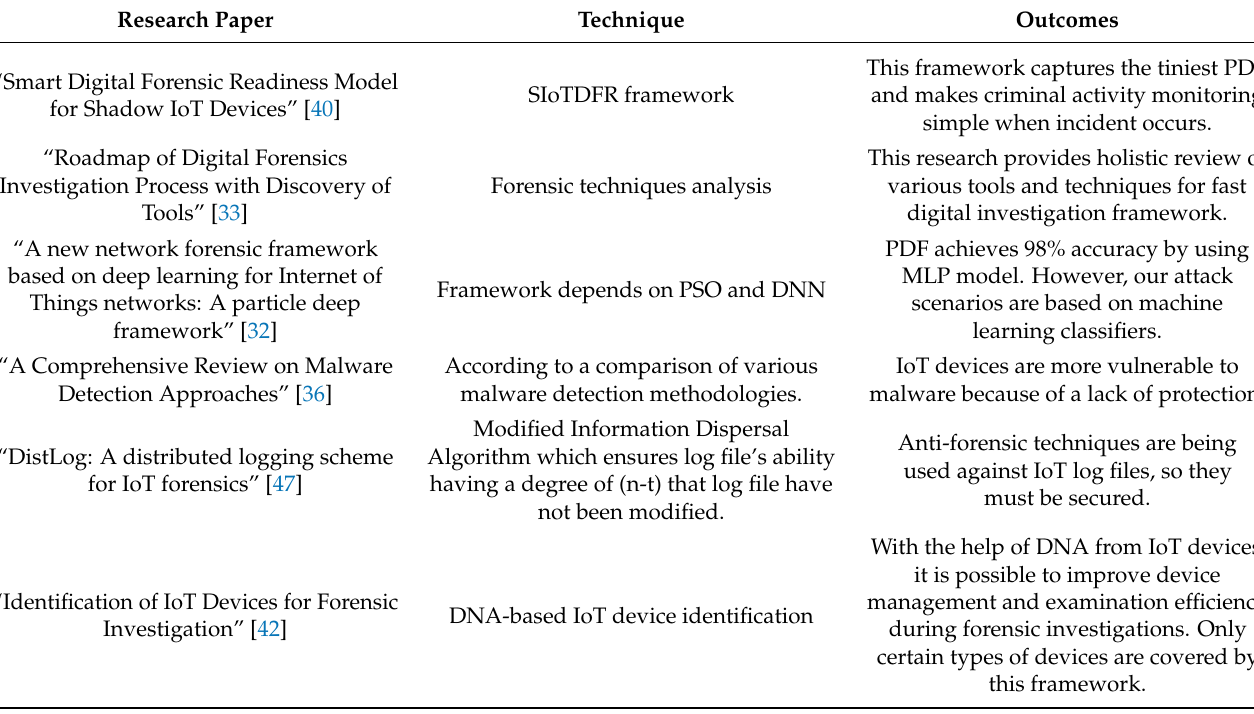
Table 1. Literature survey of forensic